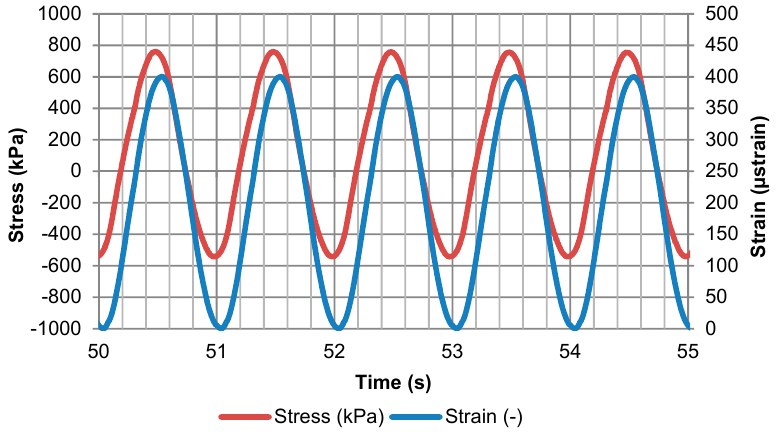
Figure 5. Example plot of stress and strain versus time/cycle number.